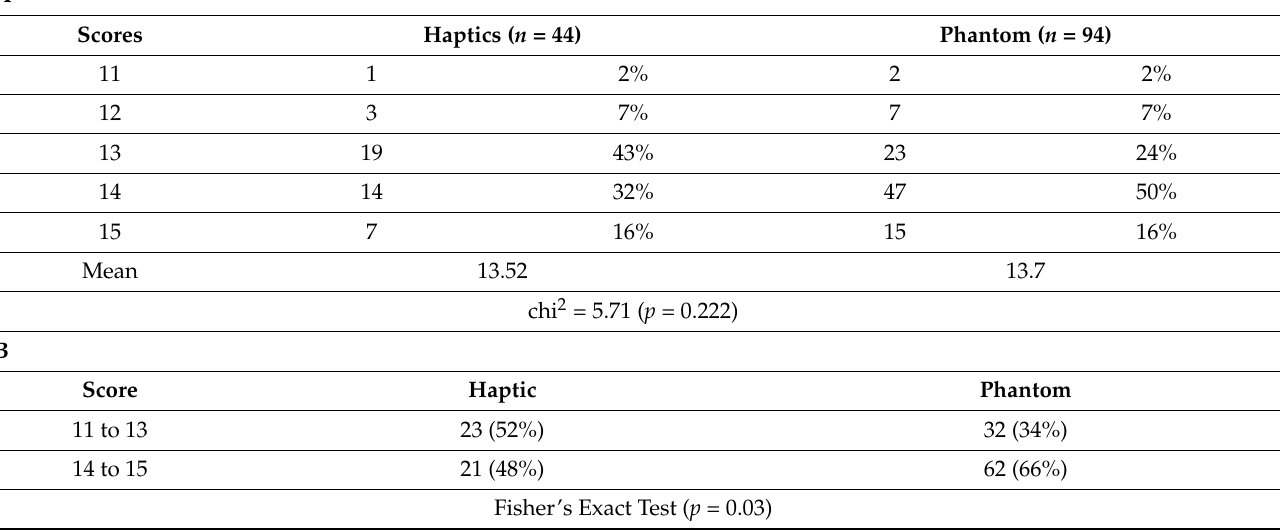
Table 2. A: Comparison on overall performance of cavity preparation (scale range 5 to 15) ( n = 138, Study 1). B: Re-coded comparison on overall performance of cavity preparation (scale range 5 to 15) ( n = 138, Study